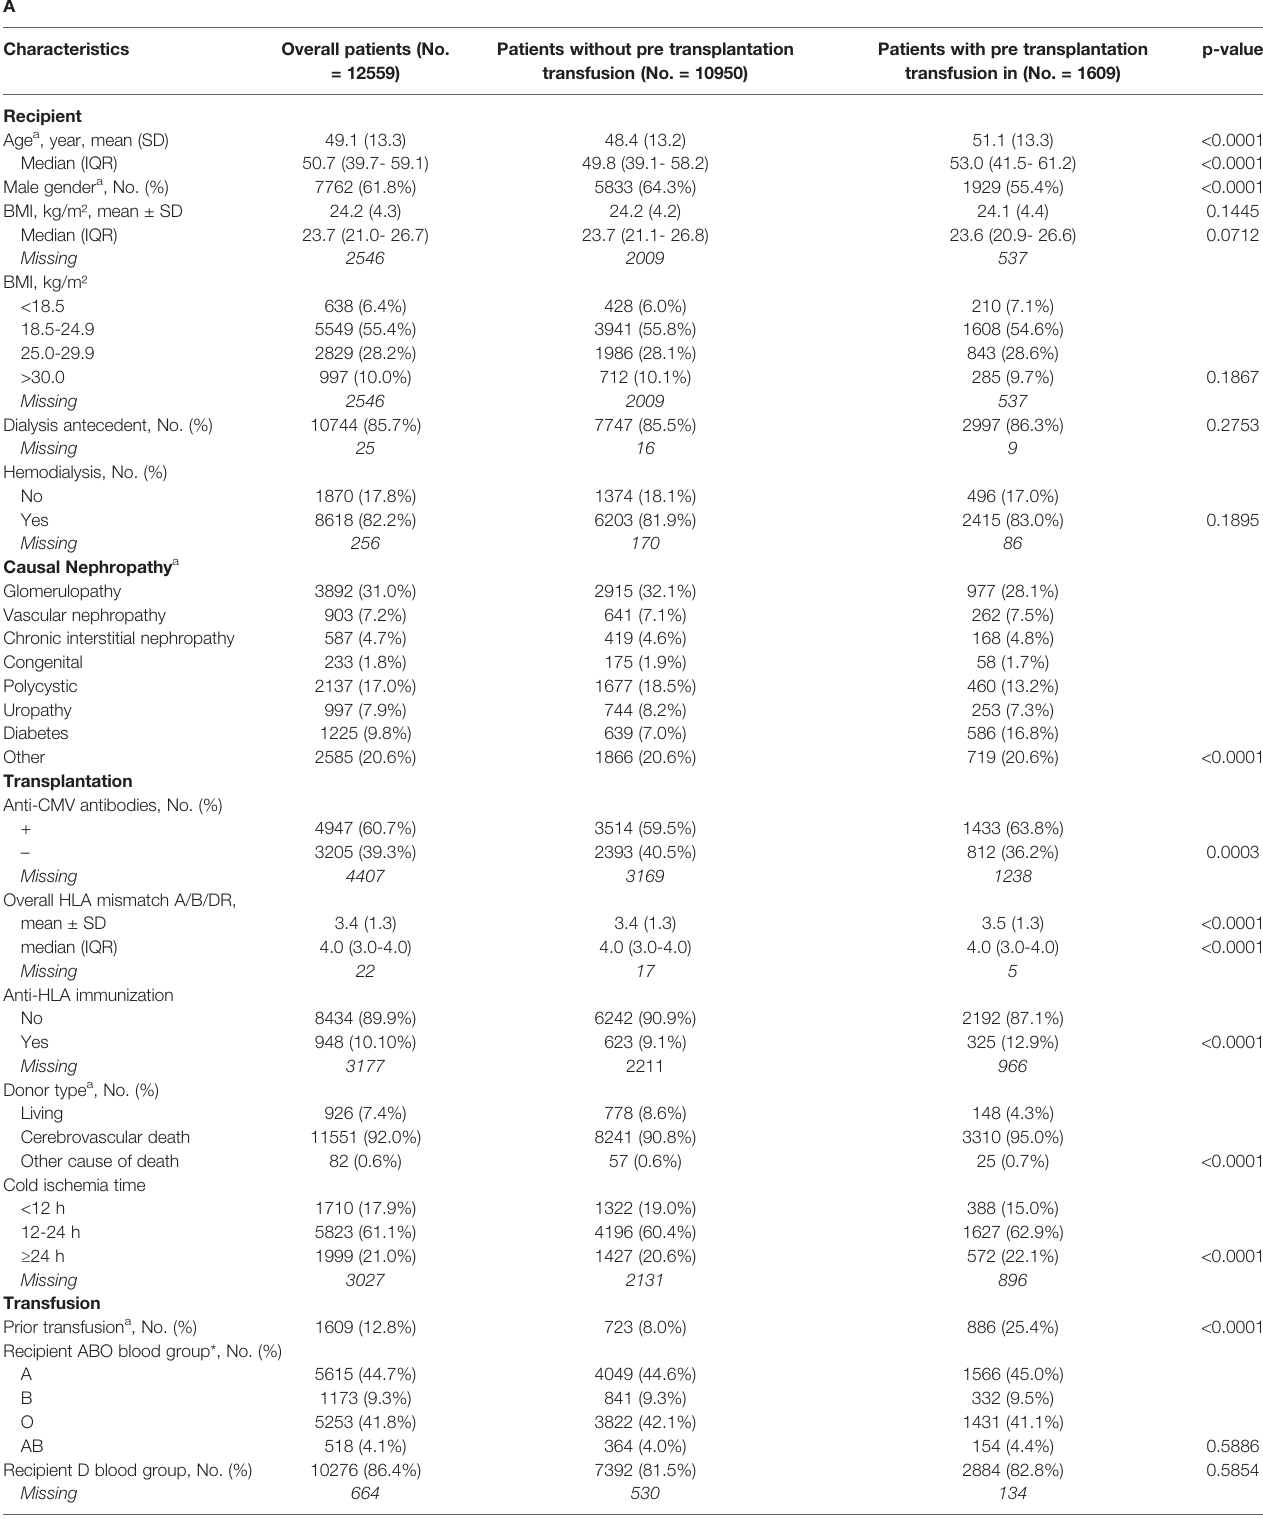
TABLE 1 | Cohort characteristics description: (A) Patient characteristics according to the presence or absence of early post-transplantation transfusions, (B) Patient characteristics according to the presence or absence of prior transfusion.